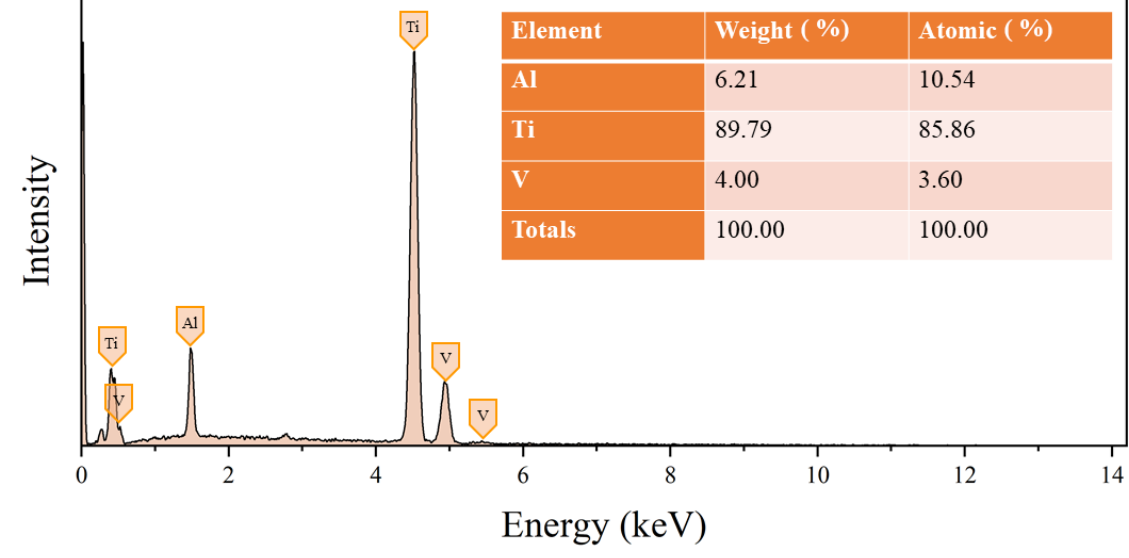
Figure 2. Chemical analysis of the initial TC4 powders. Table 1. The parameters of selective laser-melting process for fabricating the TC4